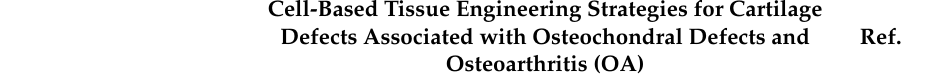
Table 4. List of studies on cell-free tissue engineering strategies for cartilage defects associated with osteochondral defects and osteoarthritis